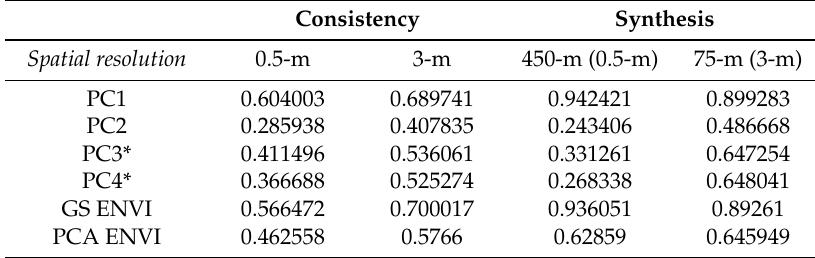
Table 10. QNR for the ASTER dataset. Values of the QNR vary between 0 and 1, the closer to 1 the result is, the more similar to the original image the fused image is. It was expected that the first two PCs have the potential to give good results when employing the PCA sharpening process, however PC3* and PC4* were used to compare the result and explain it in a wider